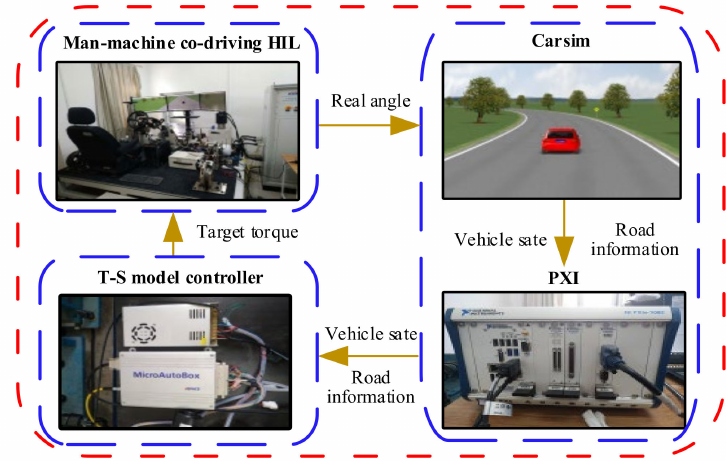
Figure 6. Semi-experimental scheme diagram of active